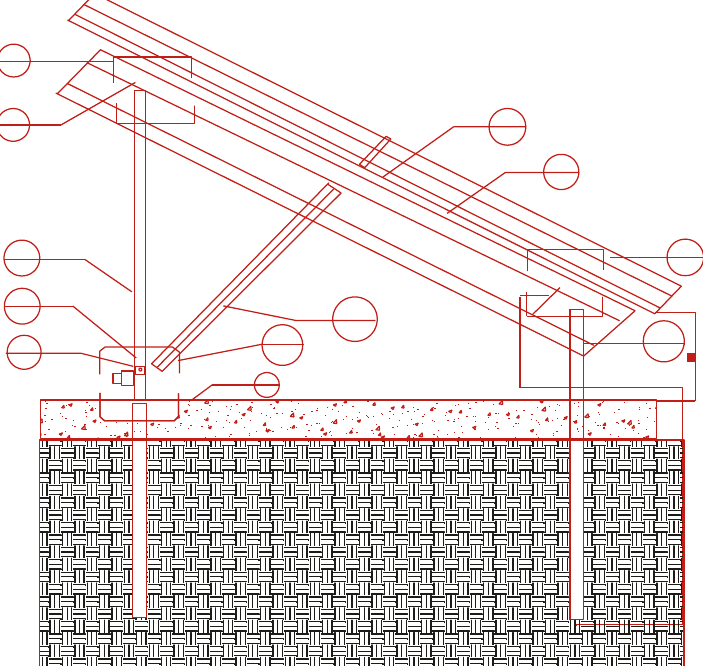
Figure 3: Support structure of solar energy photovoltaic